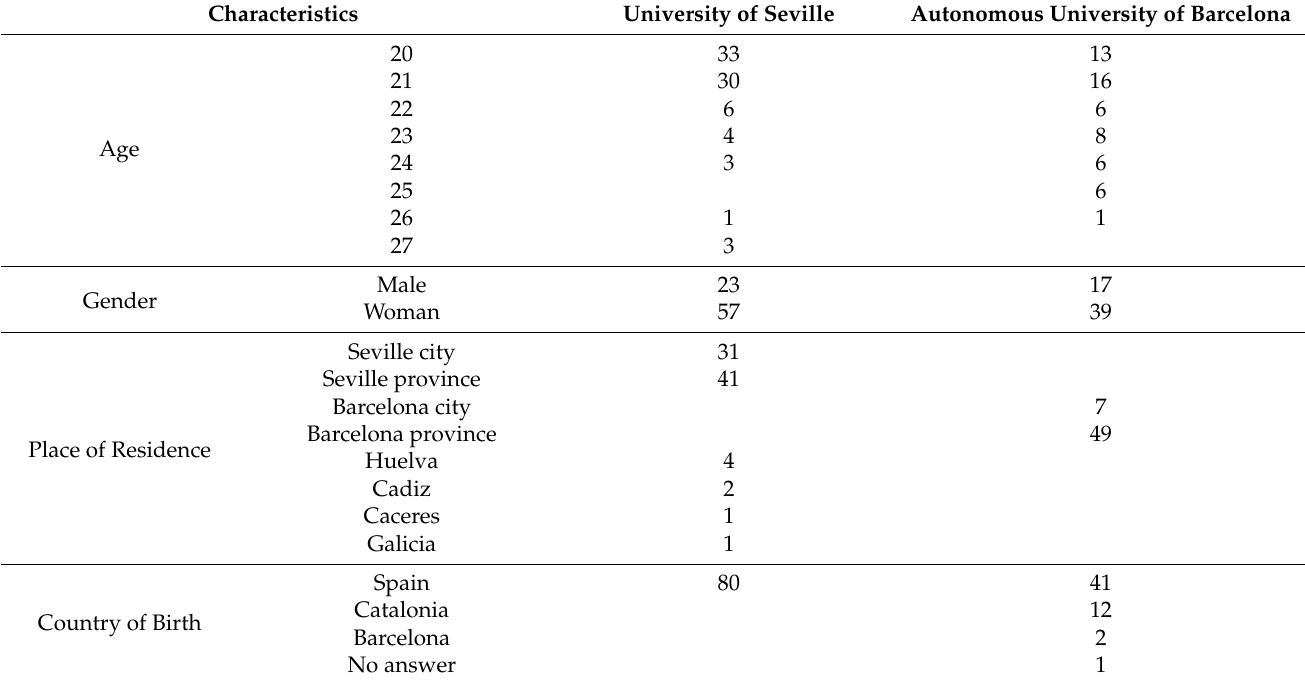
Table 1. Characteristics of the